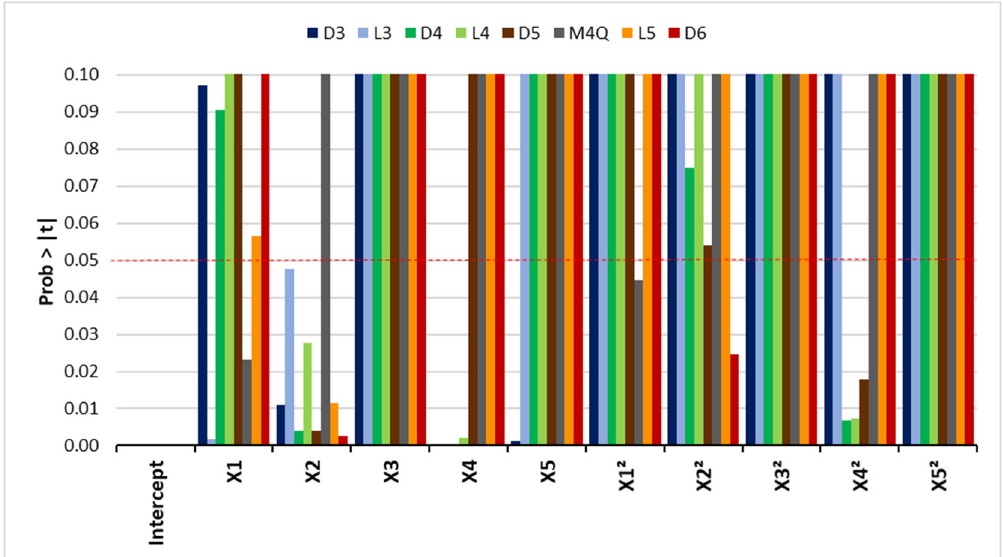
Figure 2. Results from the Student’s t-test for the main and quadratic effects.